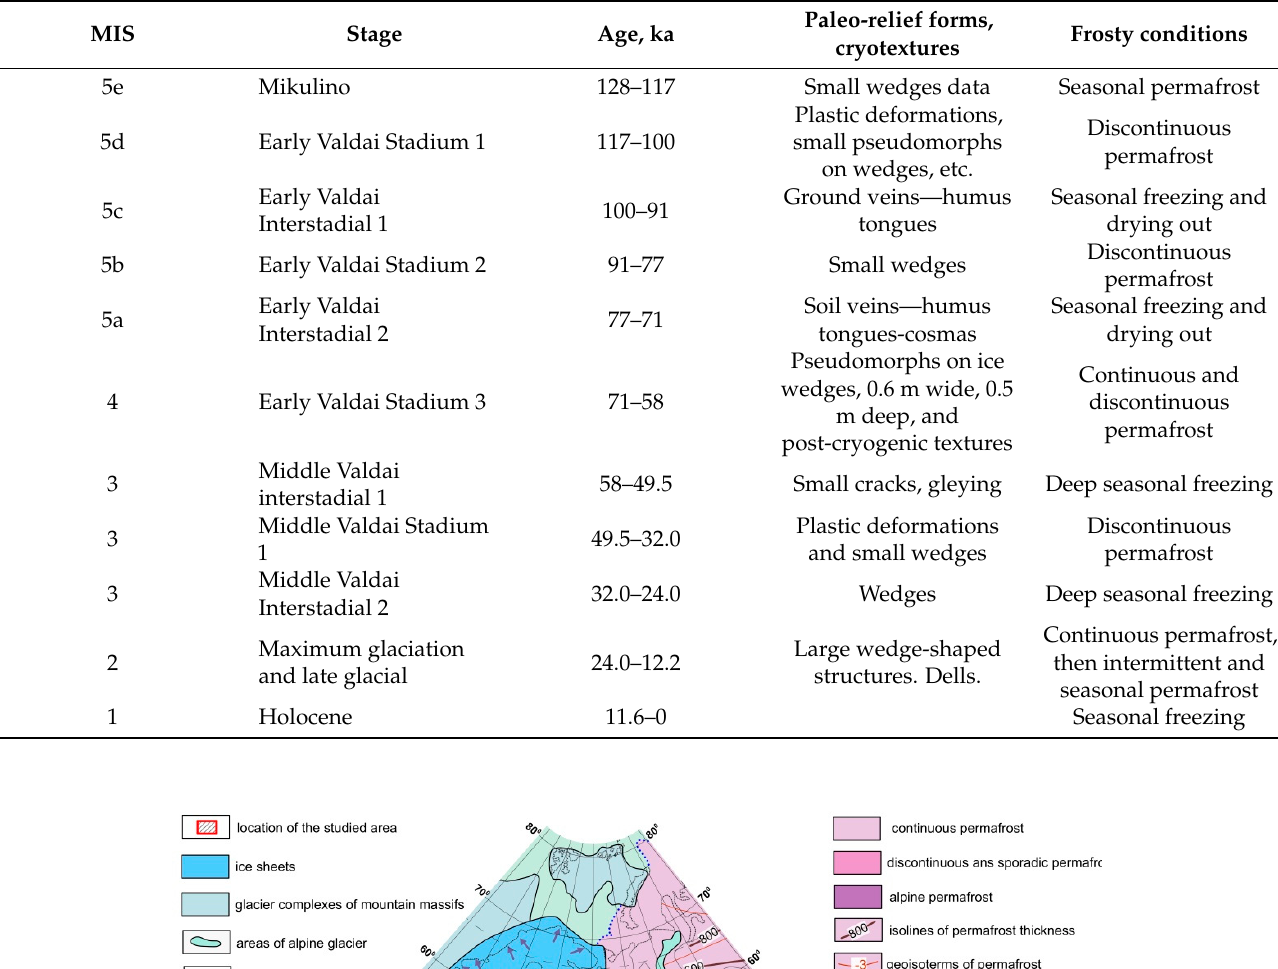
Table 1. Cryogenic sediments and soils of Pre-Volga region according to the reference section in the Aleksandrovsky quarry ([61] with changes).